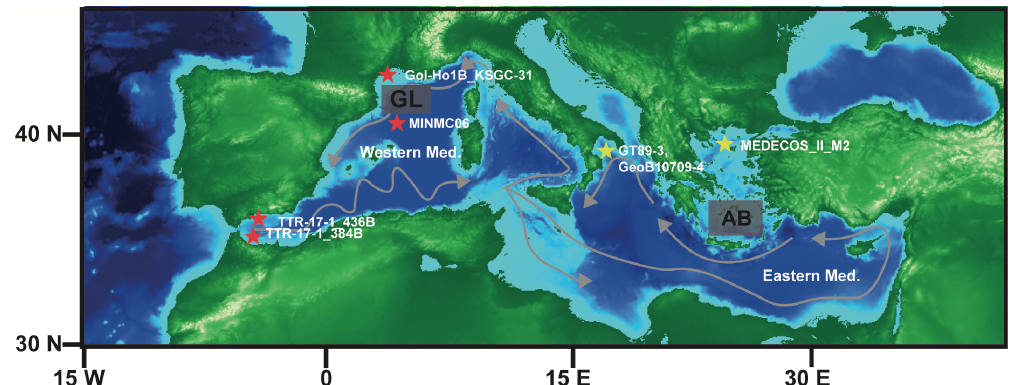
Figure 1. Map of the Mediterranean Sea modified after Incarbona et al. (2016). Grey arrows depict main surface water paths. Stars show the location of cores used to calculate the sea surface temperature (SST) gradient between western (red stars) and eastern (yellow stars) basins (W–E). Shaded rectangles show the area taken for estimation of the differential winter upward heat flux between the Aegean Basin and Gulf of Lion